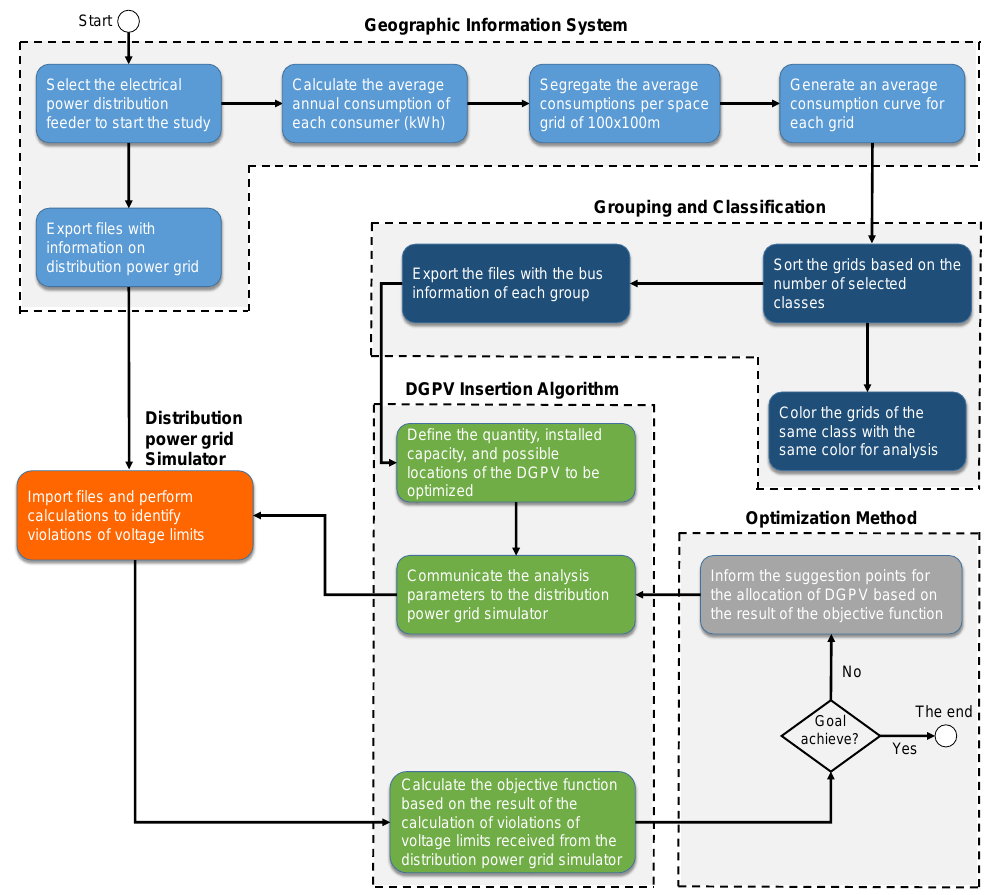
Figure 3. Flowchart of the proposed